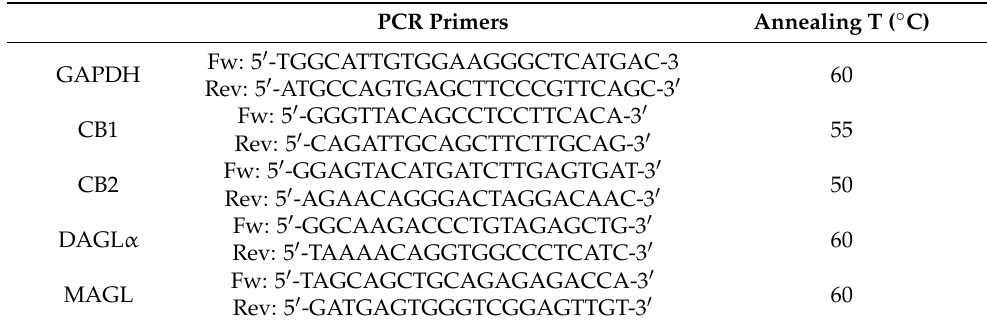
Table 1. List of the primers used for PCR